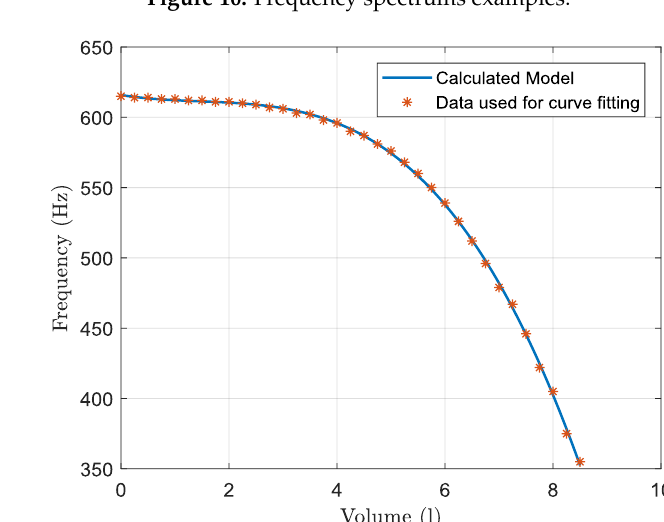
Figure 10. Frequency spectrums examples.